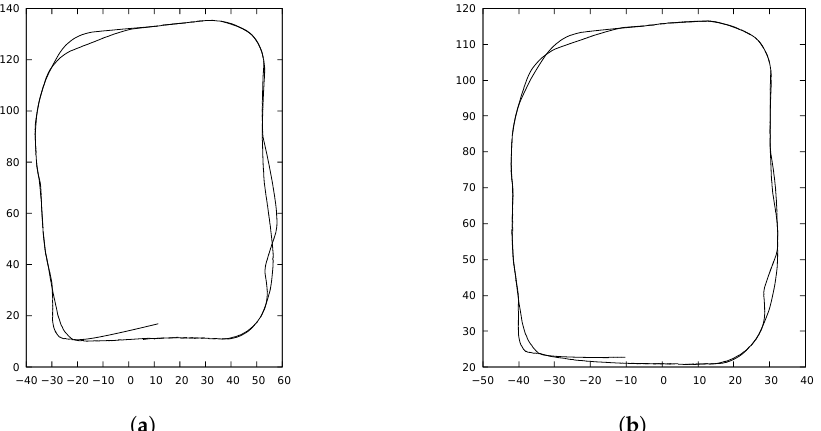
Figure 6. ExperienceMap generated in Robodeck experiment. ICP error obtained was 0.488817. ( a ) Robodeck robot path found by OpenRatSLAM. Time: 204 s. ( b ) Robodeck robot path found by xRatSLAM. Time: 38